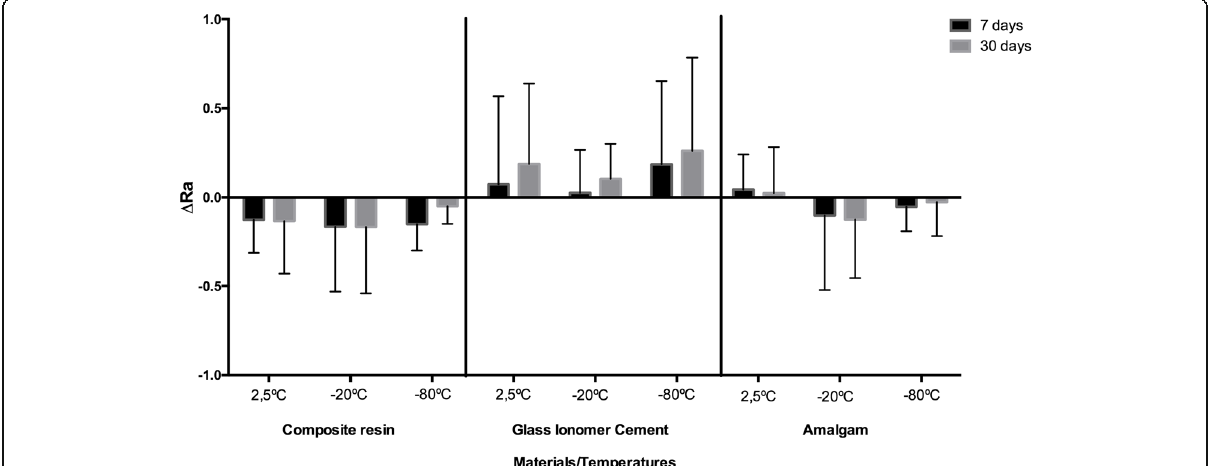
Fig. 1 Graphic representation of the comparison of Δ Ra of the materials when exposed to the cold temperatures (two-way ANOVA, repeated measures, Bonferroni test, p < .05). For all comparisons, p >